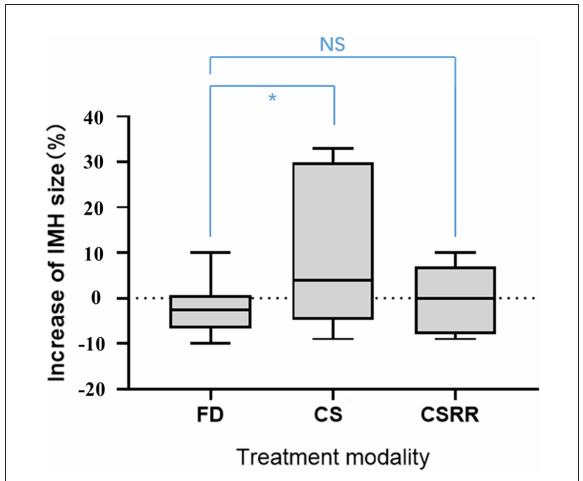
FIGURE2 Increase in intramural hematoma size according to treatment group. CS, conventional stent group; CSRR, conventional stent group excluding recurrent aneurysms; NS, no significant difference; *significant